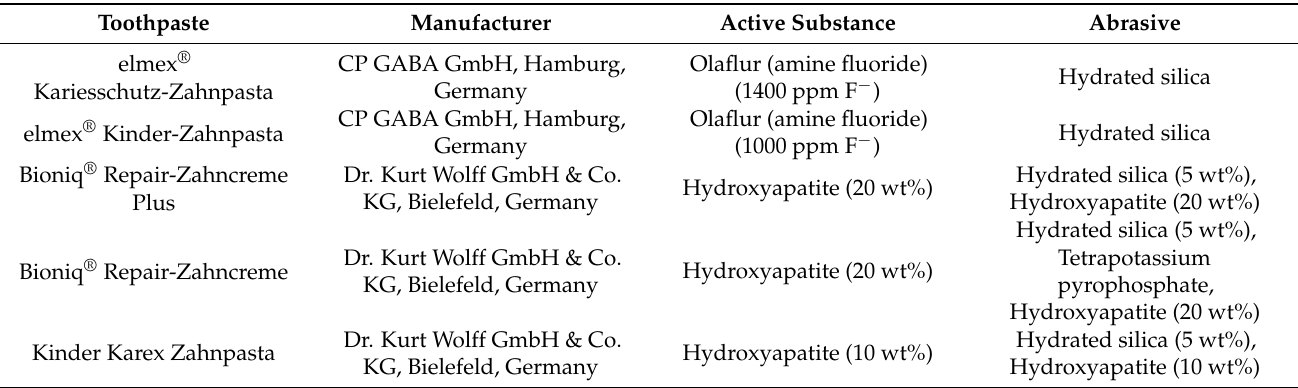
Table 3. Overview of the tested toothpastes, their main active ingredients and the abrasive and potentially abrasive